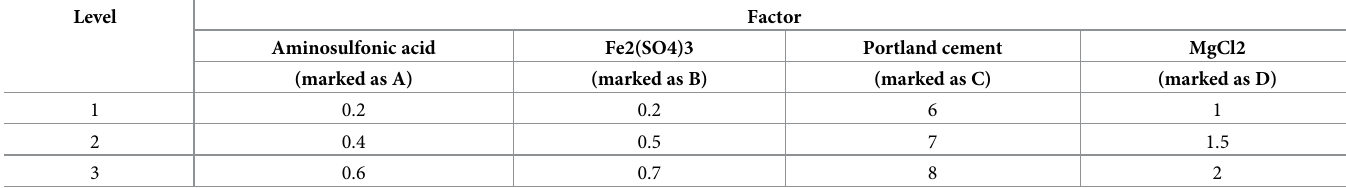
Table 2. Orthogonal experimental factors and levels of OSM complex (%).